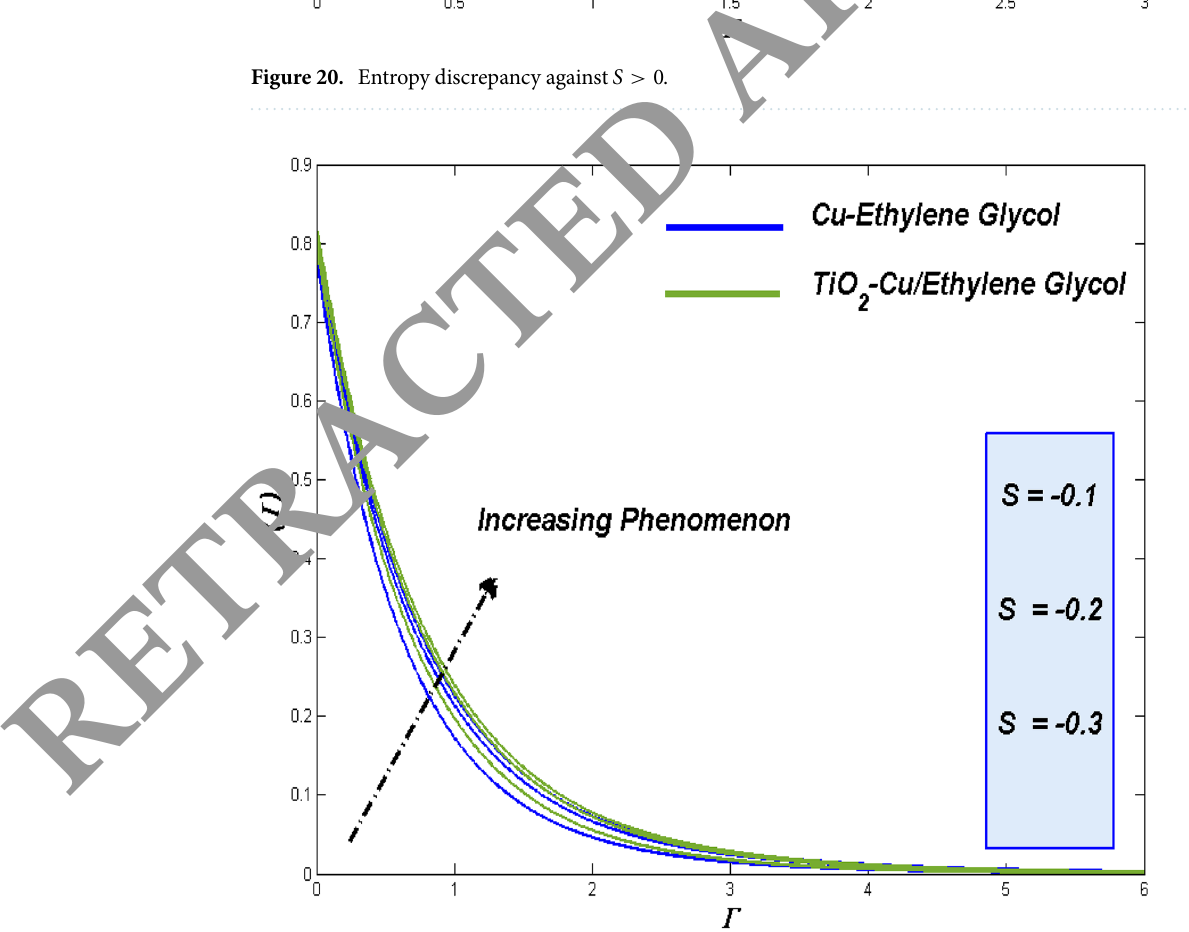
Figure 21. Velocity discrepancy against S < 0